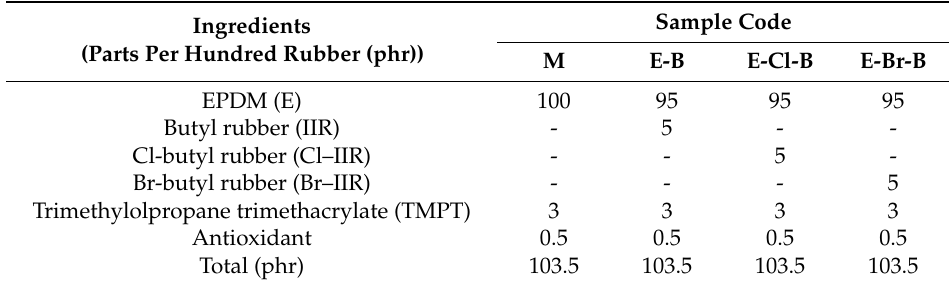
Table 1. Formulation of ethylene propylene diene monomer (EPDM)/butyl rubber